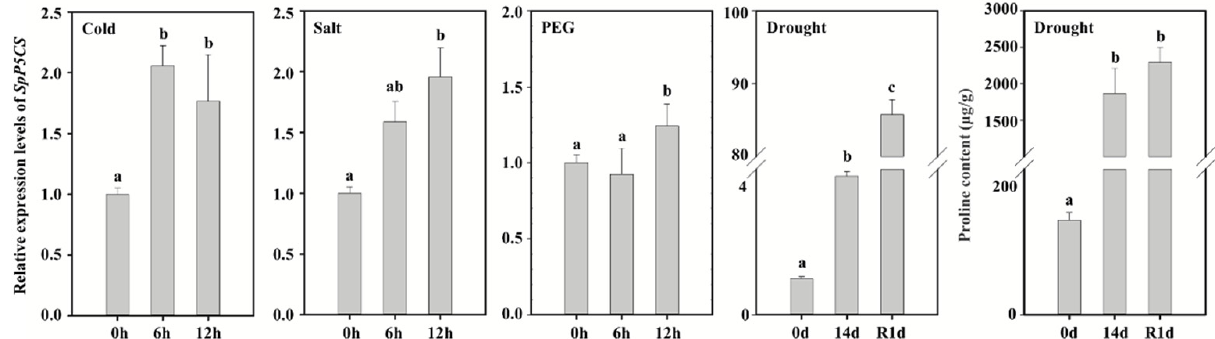
Figure 2. qPCR analysis of the expression levels of SpP5CS under cold, salt, drought and soil drought stress conditions. The experiment has three biological replicates, and the error bar denotes the standard deviation. The data are analyzed by one-way ANOVA (Tukey’s test). Different letters indicate significant differences among the relative expression levels of the genes at p < 0.05.